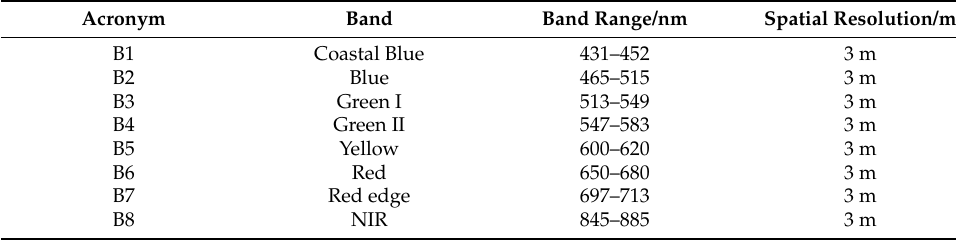
Table 1. Spectral bands of PlanetScope